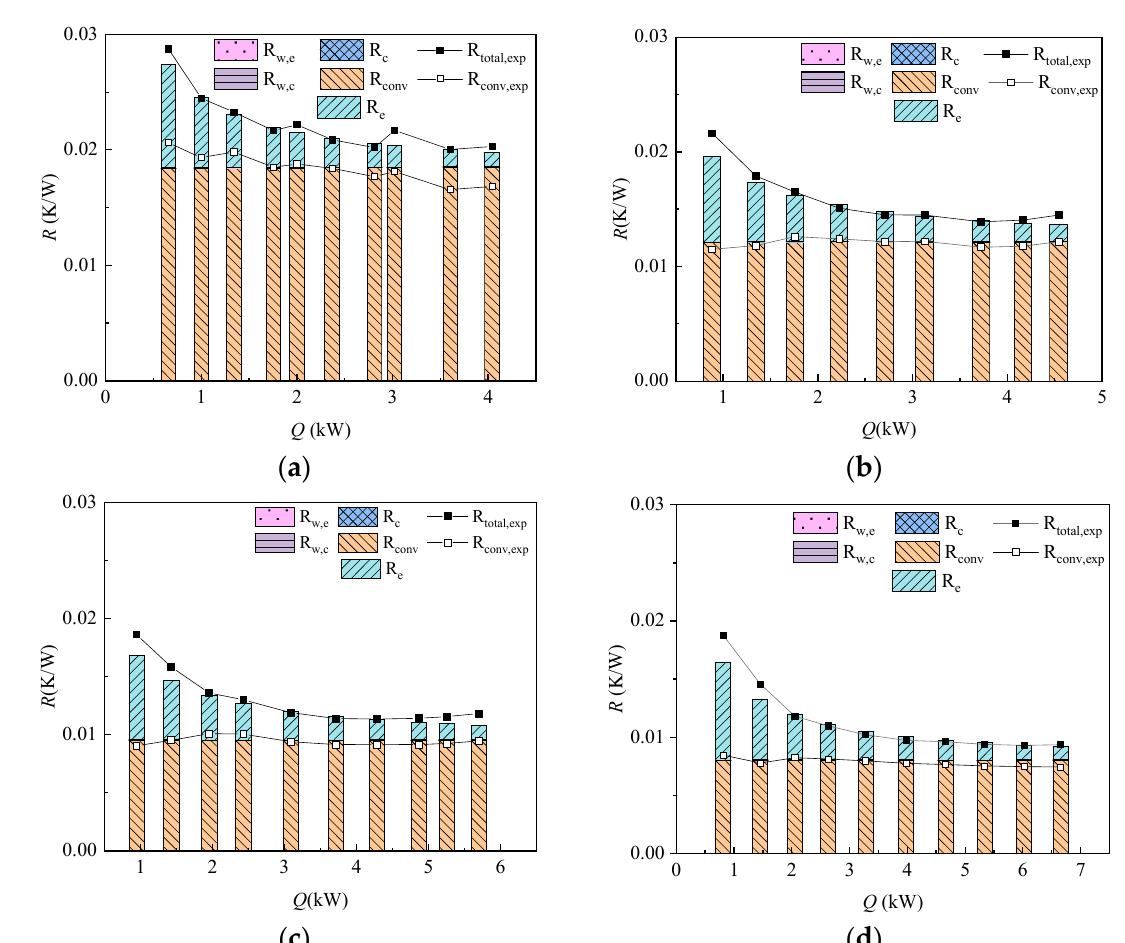
Figure 6. Decomposed theoretical thermal resistances along with the experimental total resistances under ( a ) 400CMH, ( b ) 800CMH, ( c ) 1200 CMH and ( d ) 1600 CMH.